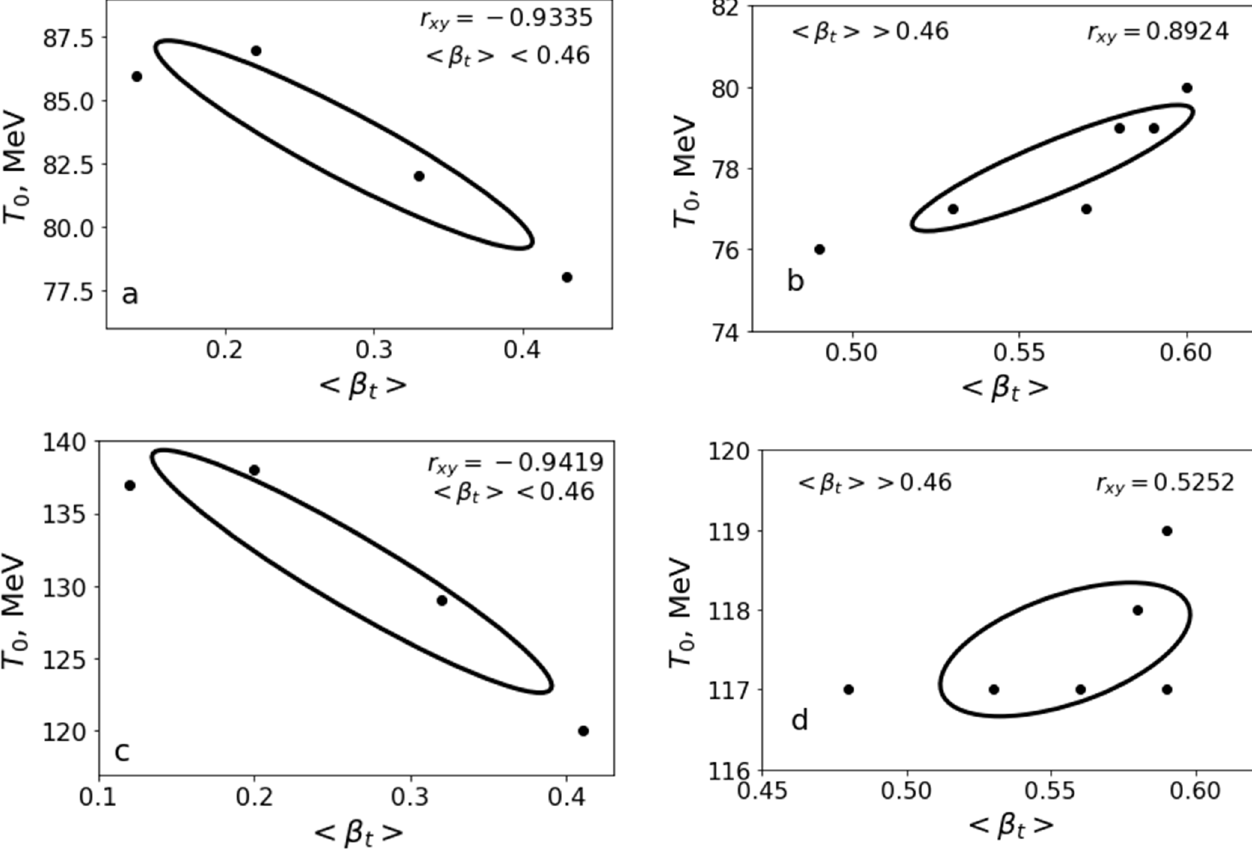
Figure 6. ( a )—Dependence of T 0 versus (cid:104) β T (cid:105) parameters ( • ) in region (cid:104) β T (cid:105) < 0.46 obtained from fits